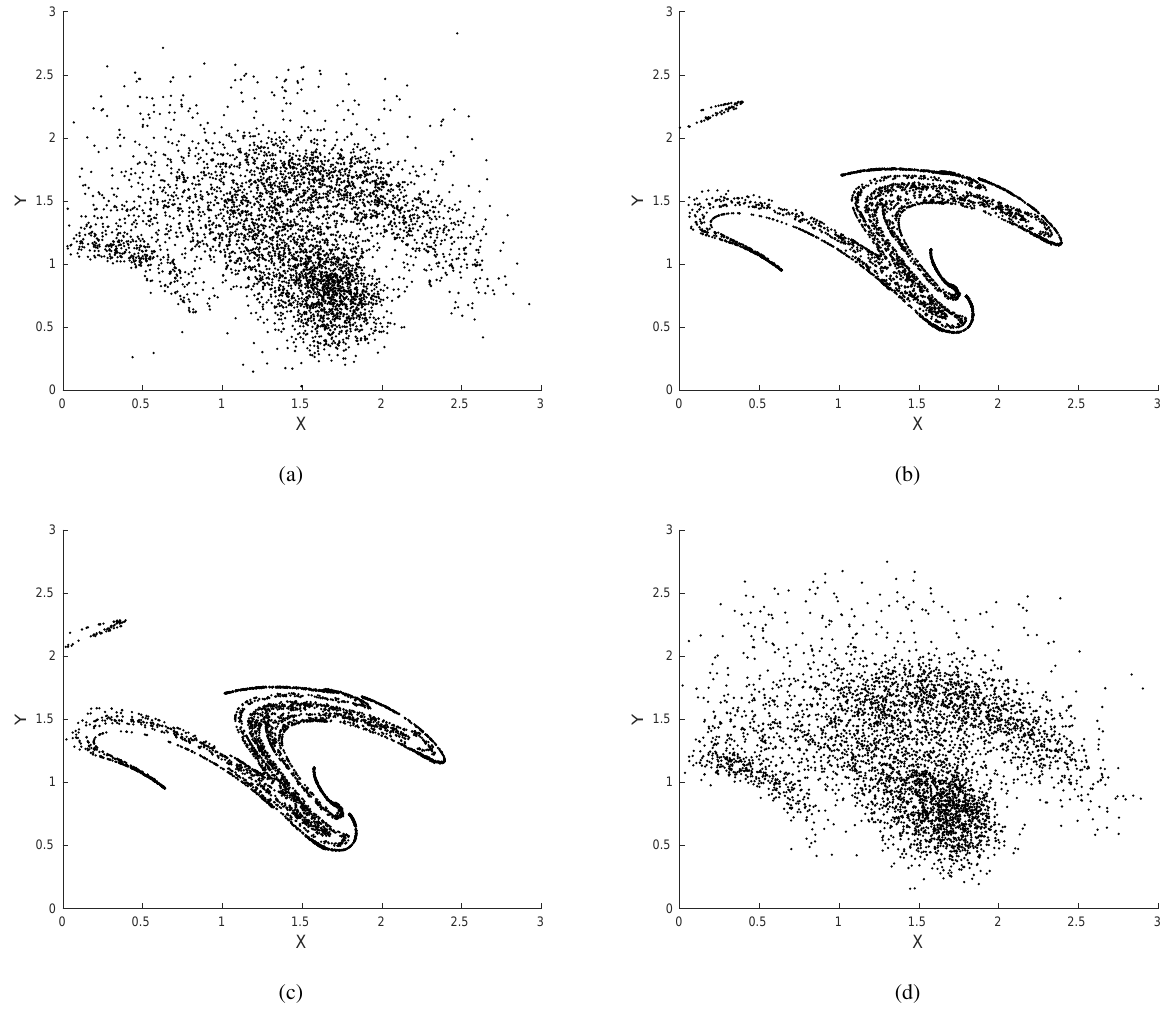
Figure 1. Poincaré section in Z = 0 of (a) coupled model, (b) uncoupled model, (c) 1st order parametrization, and (d) 2nd order parametriza- tion. For case τ = 5, the Lorenz 63 model acts as a fast forcing on the Lorenz 84